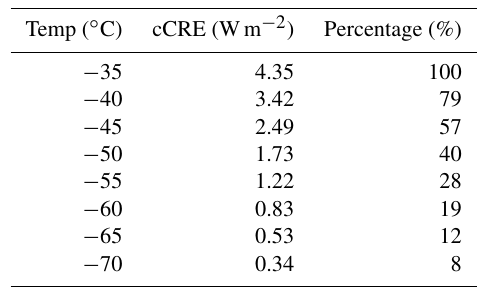
Table 3. Net cirrus cloud radiative effects (cCRE) from the fixed SST REF simulation of all clouds at temperatures colder than the one stated in the left column. The right column represents the per- centage contribution to the total